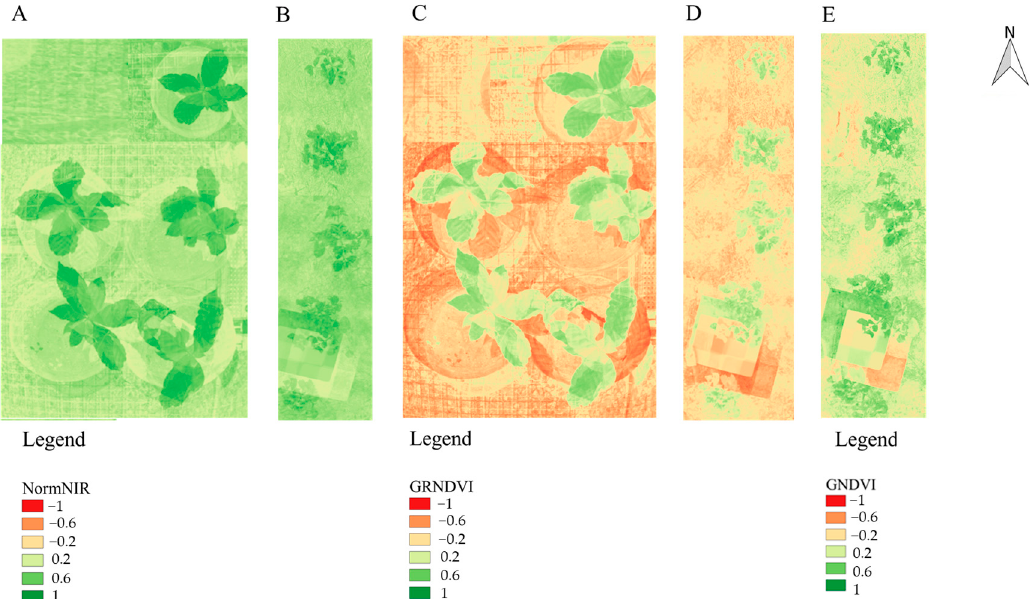
Figure 5. NormNIR Vegetation Index applied in the images ( A ): Healthy plants in the nursery, ( B ): infested plants in the field. GRNDVI applied in the images ( C ): healthy plants in the nursery, ( D ): plants infested in the field. GNDVI applied in the images ( E ): plants infested in the field. The GNDVI in healthy leaves did not show the normal distribution and therefore was discarded from the comparisons. The NormNIR and GRNDVI observed significant differences in healthy and infested plants. By visual analysis, the GRNDVI was the VI that best differentiated healthy plants from infested plants (Figure 5C,D).